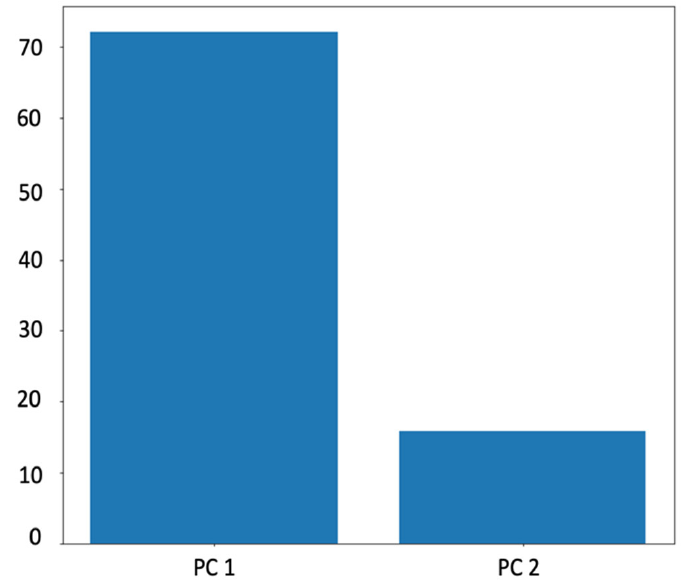
Figure 9. Variance in CP1 and CP2.